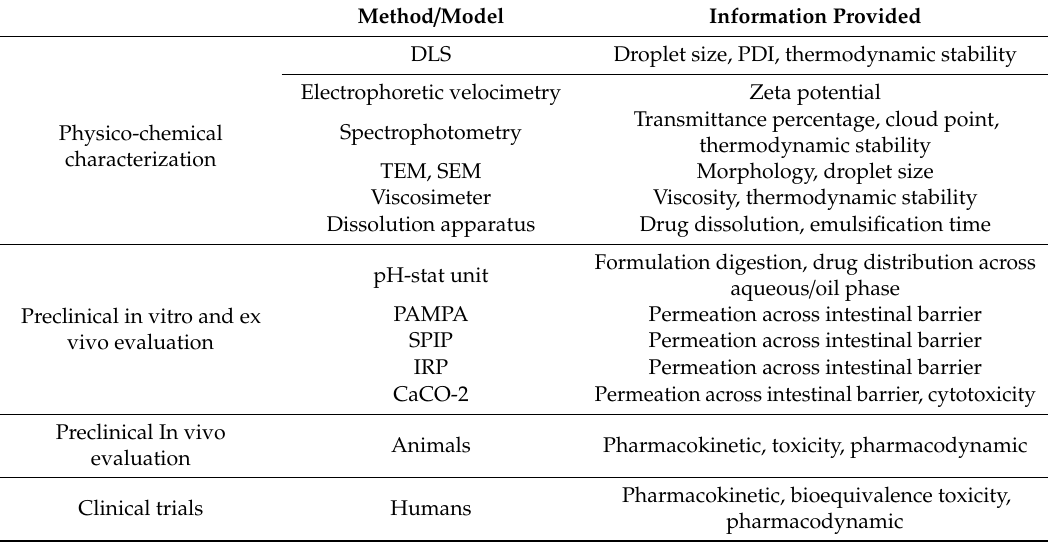
Table 2. The general methods and models used to evaluate